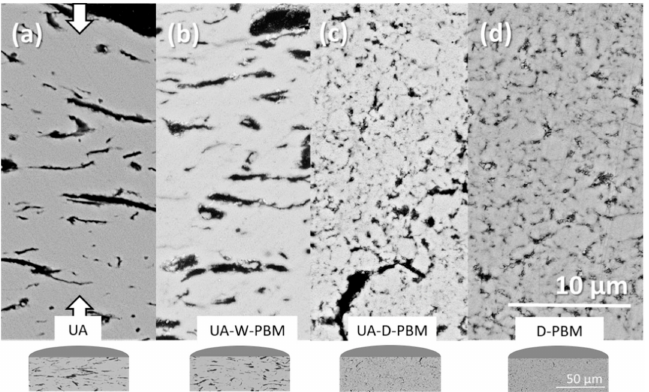
Figure 1. Backscattered electrons (BSE)-SEM images of the polished cross sections of the composites prepared from graphene nanoplatelets (GNP) and 3YTZP powders mixed by different routines: ( a ) ultrasonic agitation, ( b ) ultrasonic agitation followed by wet planetary ball milling, ( c ) ultrasonic agitation followed by dry planetary ball milling and ( d ) dry planetary ball milling. The same scale